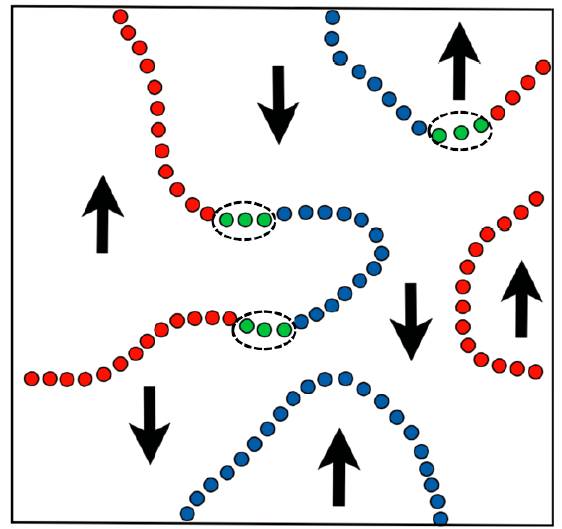
Figure 5. Twin plane with local dipole moments in the up and down direction. Bloch lines limit the domains within the twin wall where the dipole direction is either out of the plane (red) or into the plane (blue). Bloch vortex points, where two Bloch lines with different polarity join, are indicated in green [22].